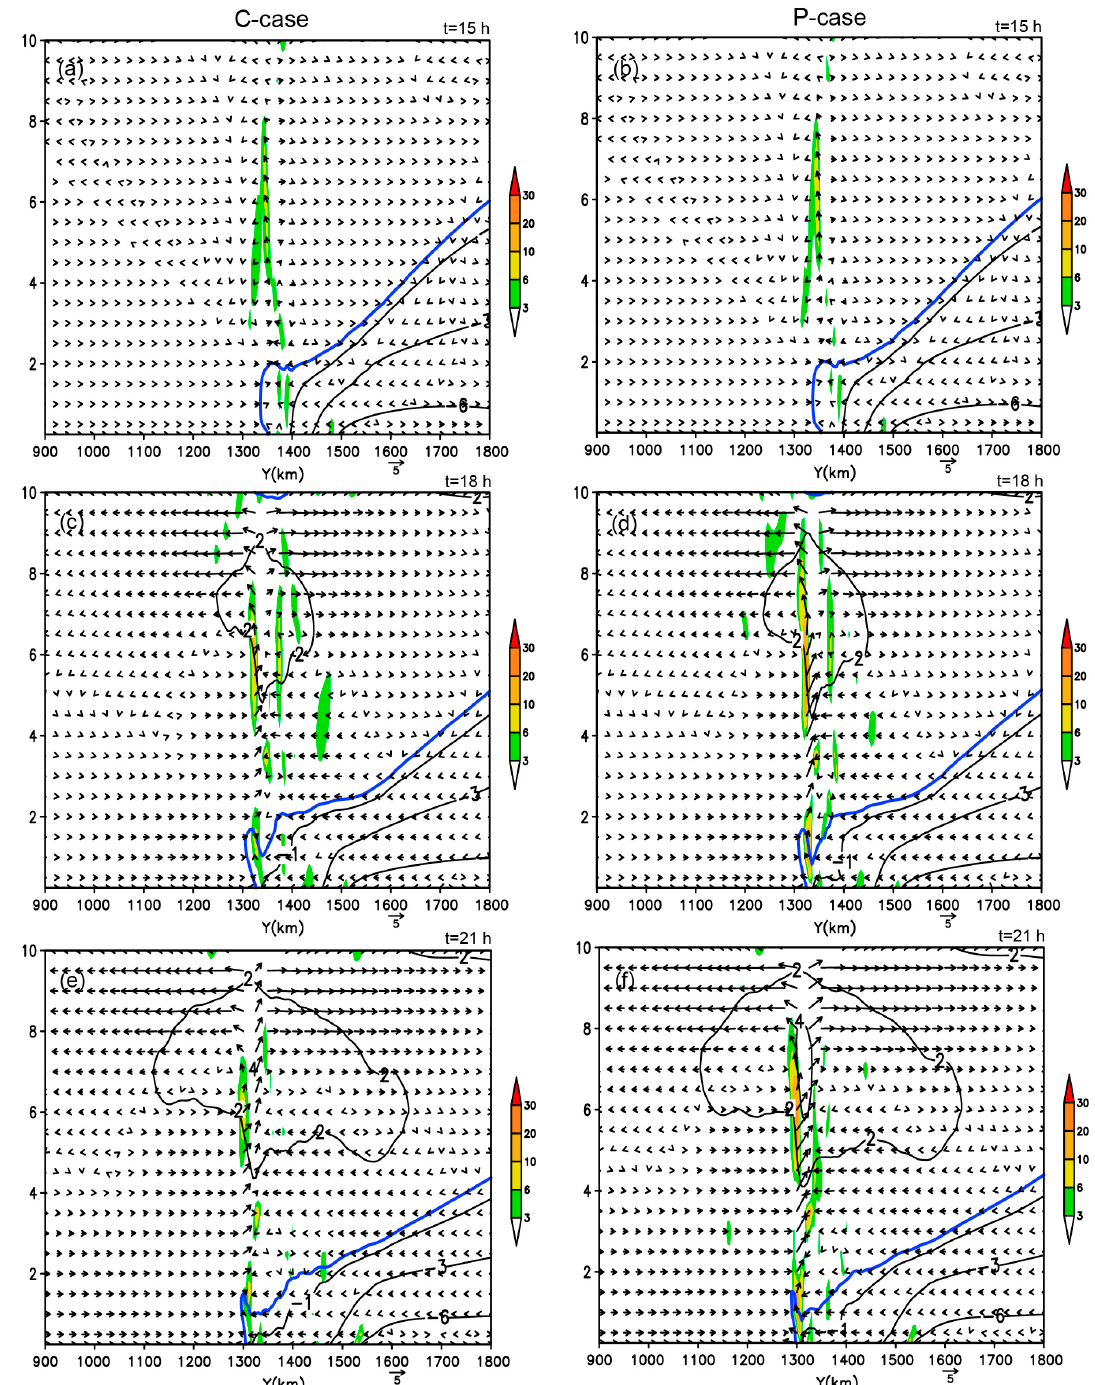
Figure 13. Vertical cross sections of zonal mean virtual potential temperature perturbation ( θ (cid:48) v , 1.0 K contour interval), the tendency of the virtual potential temperature gradient (shading shows greater than 3 k/100 km · h) and cross-front wind perturbation vectors ( v (cid:48) , w ) at ( a , b ) t = 15 h, ( c , d ) 18 h and ( e , f ) 21 h. Negative contours are solid. The blue thick solid line highlights -0.5 K isopleth of virtual potential temperature perturbation in order to approximately delineate the leading edge of the front in the lower troposphere. Only a 900 km × 10 km of the domain is presented. The left panels show C-case, the right panels show P-case.